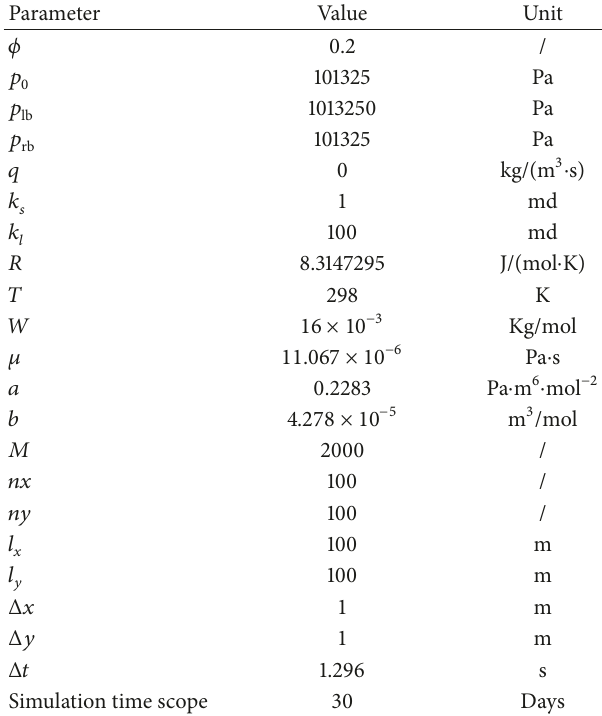
Table 1: Computational